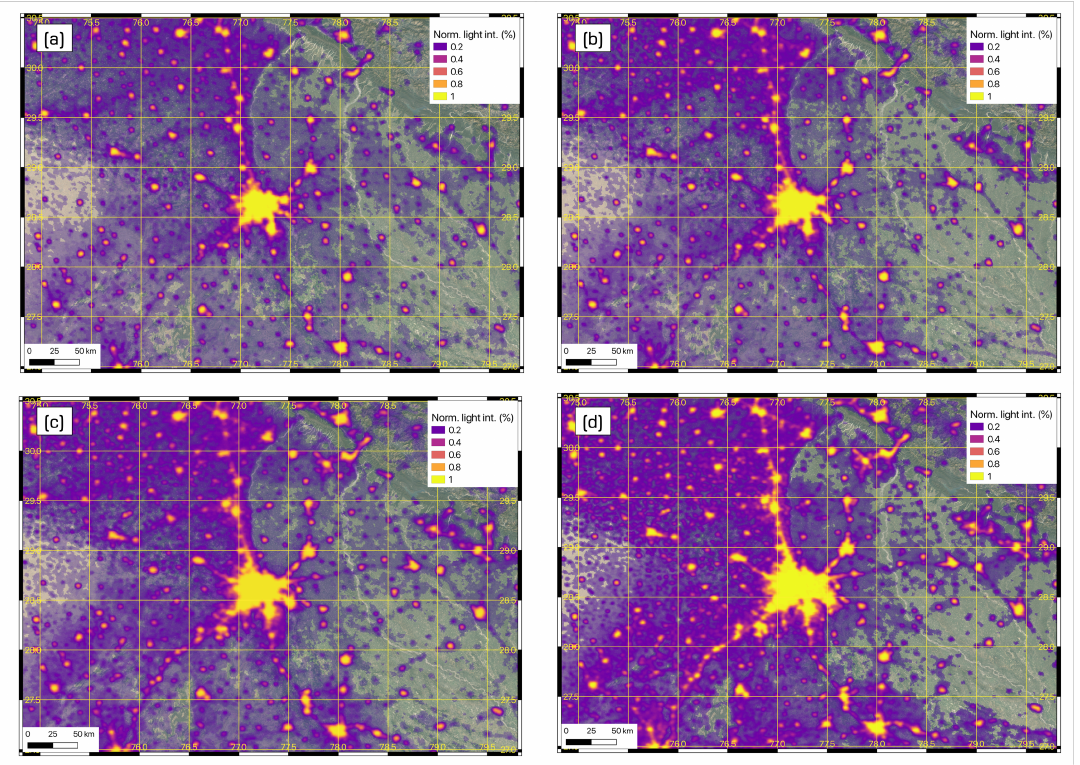
Figure 1. Normalized DMSP night-time light intensity maps (as a proxy for urban and population densities) for the city of New Delhi, in India, for the years ( a ) 1998, ( b ) 2003, ( c ) 2008, and ( d ) 2013. These maps show a significant urban growth that can be observed in a time horizon shorter than five